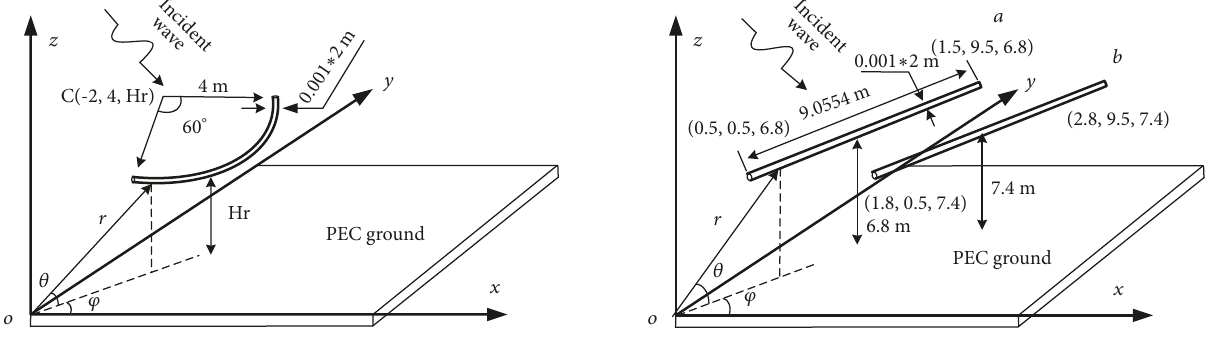
wire antenna radiation. The voltage with unit amplitude is set to the middle of the wire. The two curves coincide with each other, as shown in Figure 4.